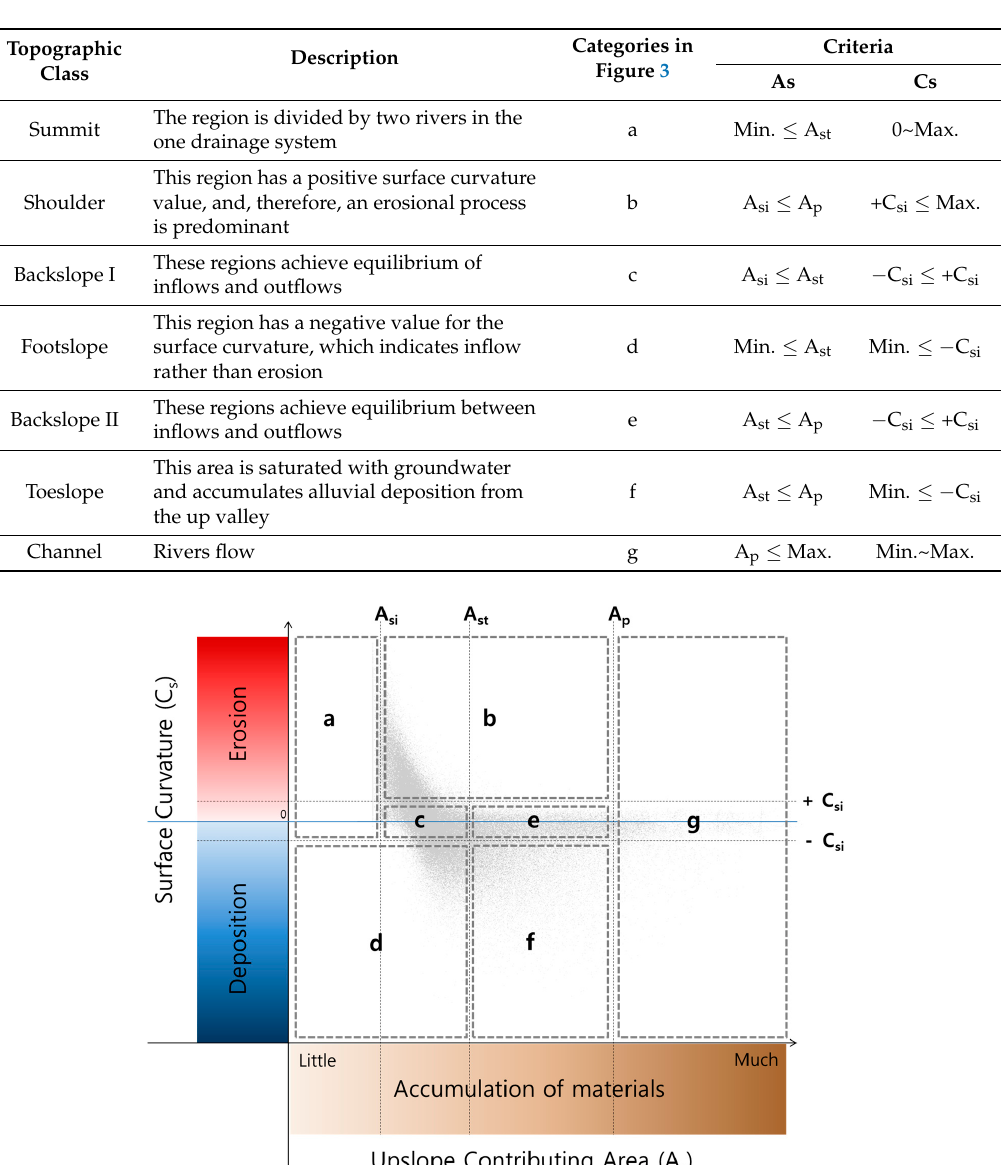
Table 2. Generic topographic classes divided by the upslope contributing area (As) and the surface curvature (Cs). The criteria for As and Cs were set by the level of sediment transport and the amount of sediment [27,47].